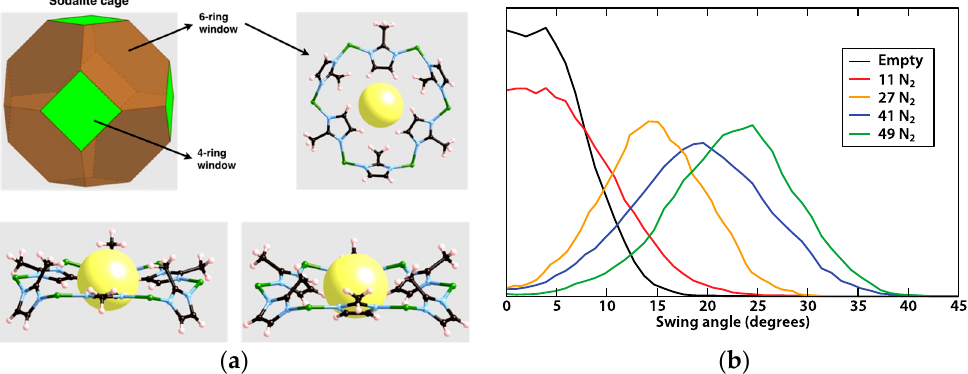
Figure 20. ( a ) Depiction of the “out of plane” swinging motion of the methylimidazolate linkers in the 6-ring window of ZIF-8 material, with sodalite topology; ( b ) distribution of swing angle due to thermal motion at 300 K, in the evacuated material and in presence of N 2 adsorbate molecules. Reproduced with permission from [35]. Copyright Wiley-VCH, 2017.